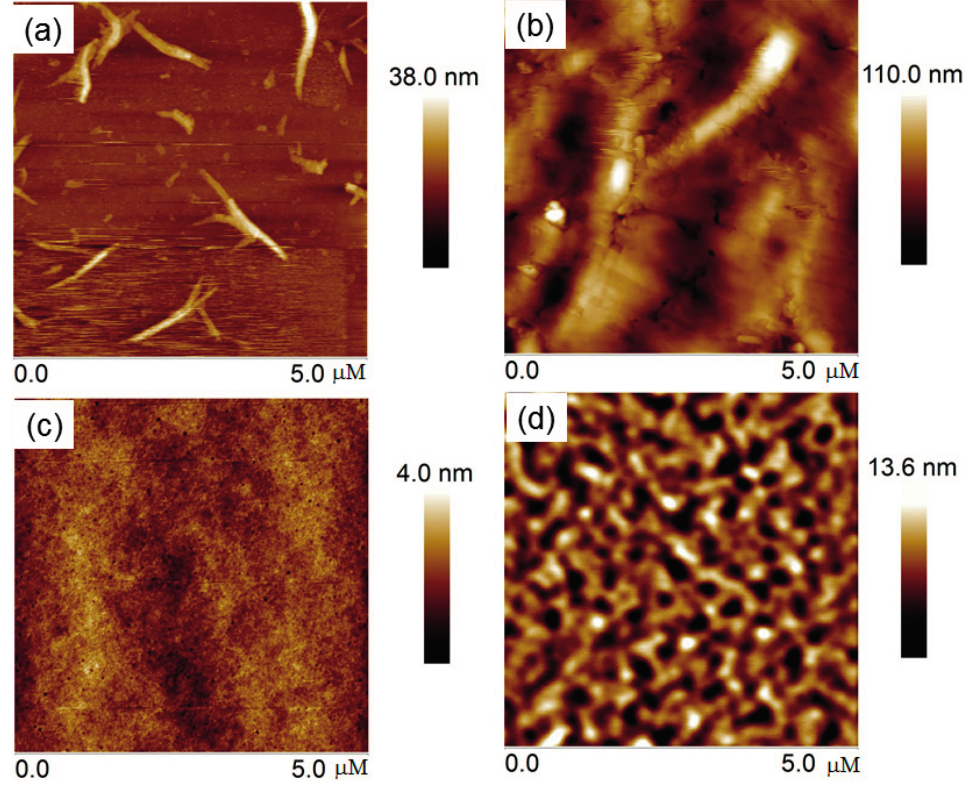
Figure 8. The AFM images of S10 ( a , b ) and S11 ( c , d ) for as-cast and thermally annealed